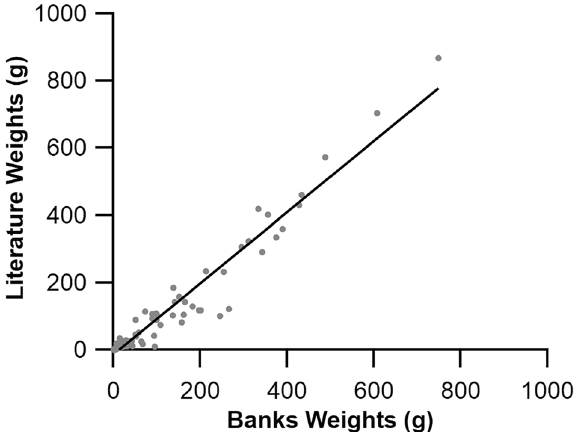
Figure 5. Comparison of muscle masses. Comparison of human muscle masses taken from Banks (2006) and comparative muscle architecture publications (see ESM1). R 2 = 0.95, P <